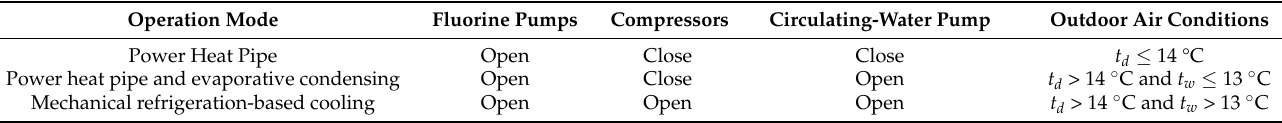
Table 3. Unit operation mode.